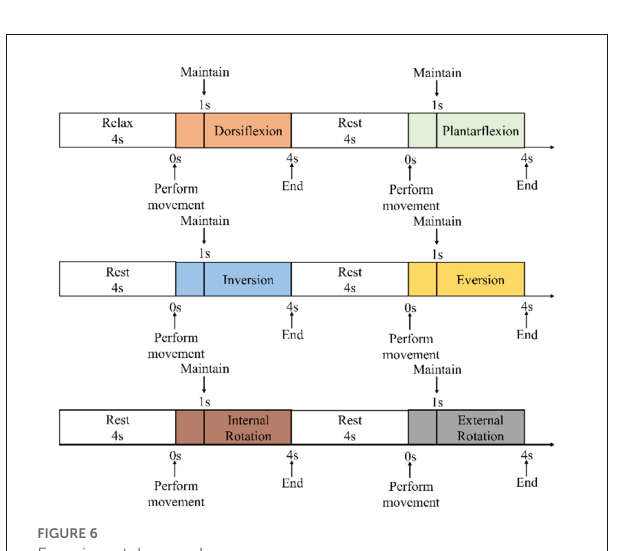
FIGURE6 Experimental procedure. speed during the experiment. At the same time, the subjects moved their ankles along with the animation. During the experiment, the same animation also appeared on the computer monitor to help the subjects move at a constant speed.